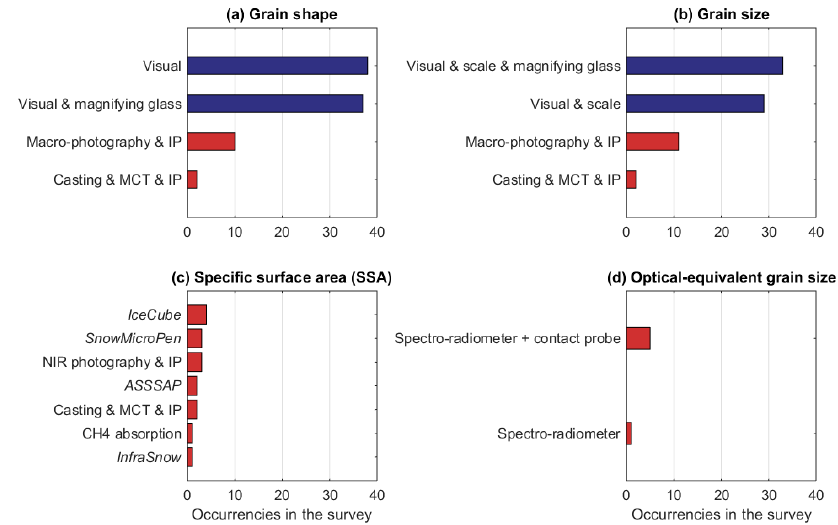
Figure 9. Occurrences of the applied instruments to measure snow microphysical properties, such as grain shape ( a ), grain size ( b ), specific surface area (SSA) ( c ), and thermal conductivity ( d ). The abbreviations IP and MCT stand for image processing and micro-computed tomography, respectively. Different colors denote manual instrument without electronics (blue) and manual instrument with electronics (red).